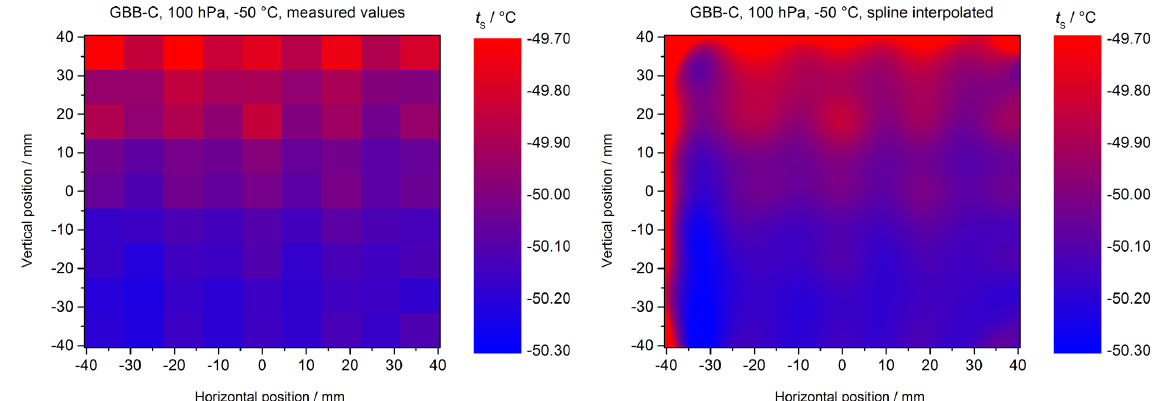
Fig. 15. The spatial distribution of the radiation temperature of the GLORIA blackbody GBB-C at a nominal temperature of − 50 ◦ C and 100 hPa. The field-of-view is 82 mm × 82 mm. The measured data is shown on the left panel, the spline interpolated data on the right. The homogeneity is 132 mK (standard deviation).